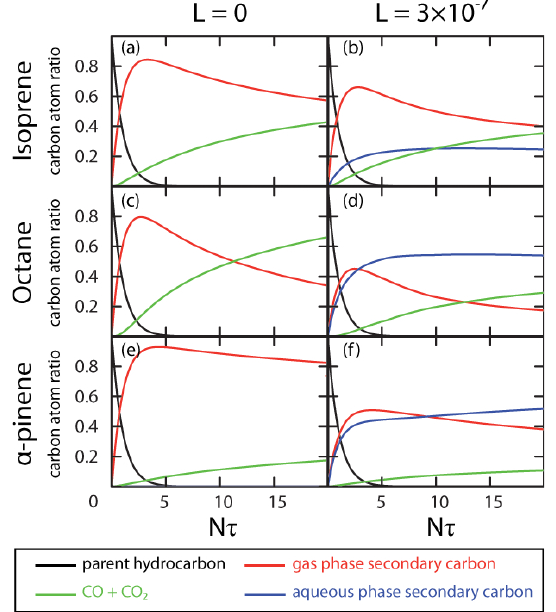
Fig. 1. Carbon budget during the oxidation of isoprene (top row), octane (middle row) and α -pinene (bottom row) for liquid water content of 0 (1st column) and 3 × 10 − 7 (2nd column), under inter- mediate NO x conditions (NO x = 1ppb). The time scale is defined as multiples of lifetimes of the initial hydrocarbon, as described in the